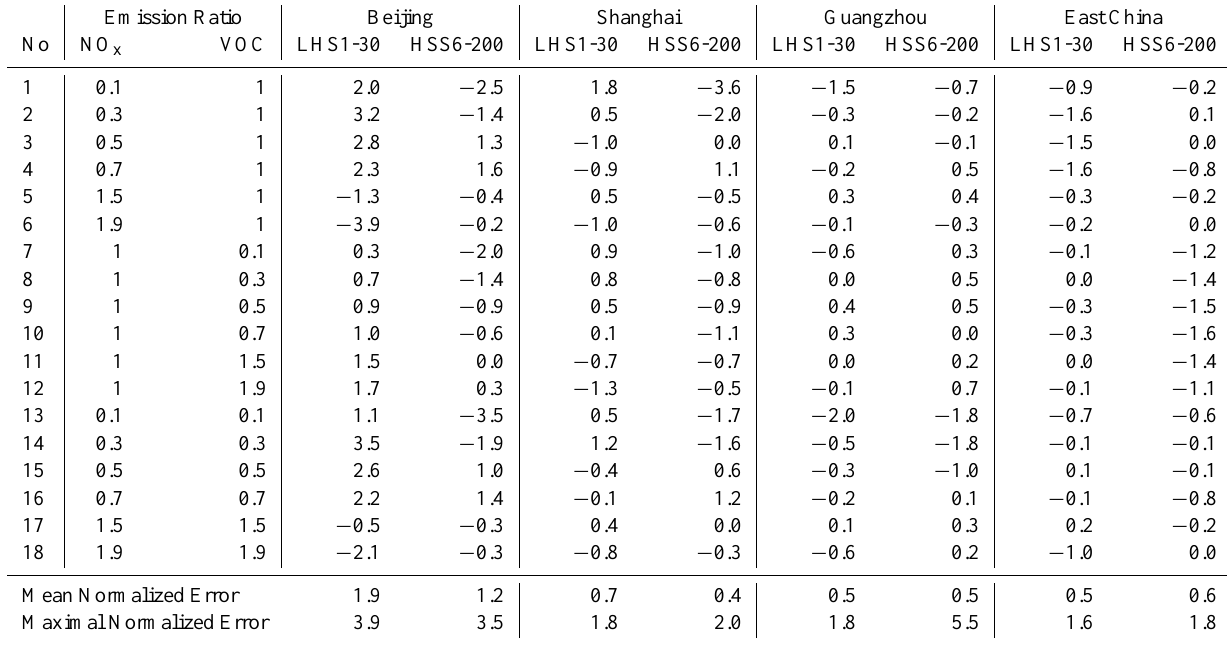
Table 3. Normalized errors of RSM predicted daily 1-hour maximum ozone mixing ratio compared to simulated result by CMAQ through out-of-sample validation, %. Emission Ratio